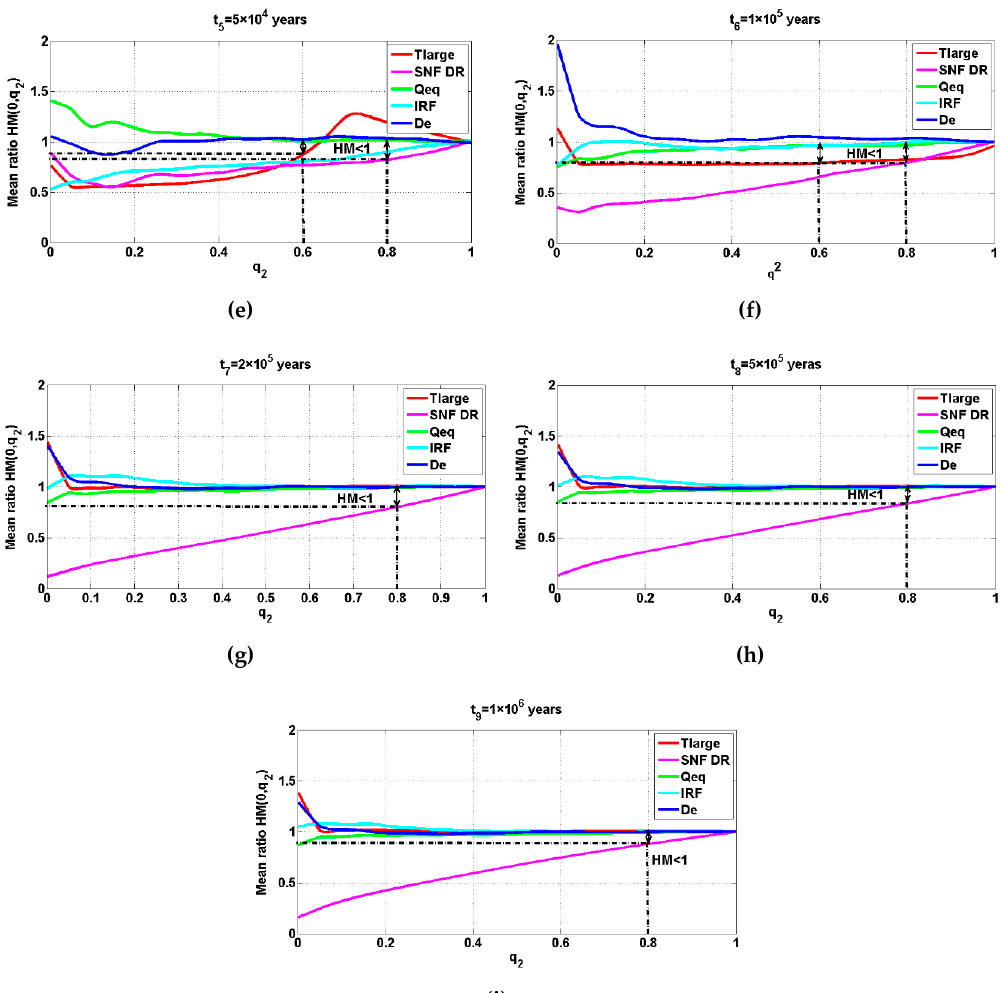
Figure 11. Ratio of the mean (smoothed by the regression technique) due to the decreased upper bound of the range of parameters (Tlarge, SNF DR, Qeq, IRF, De) for different time points: ( a ) at 1 × 10 3 years after repository closure; ( b ) at 5 × 10 3 years after repository closure; ( c ) at 1 × 10 4 years after repository closure; ( d ) at 2 × 10 4 years after repository closure; ( e ) at 5 × 10 4 years after repository closure; ( f ) at 1 × 10 5 years after repository closure; ( g ) at 2 × 10 5 years after repository closure; ( h ) at 5 × 10 5 years after repository closure; ( i ) at 1 × 10 6 years after repository closure (Tlarge—defect size enlargement